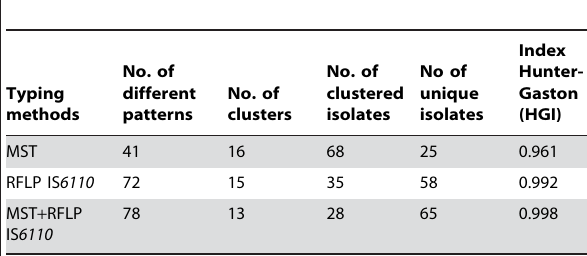
Table 3. Discriminatory power of MST compared to RFLP- IS 6110 used alone and in